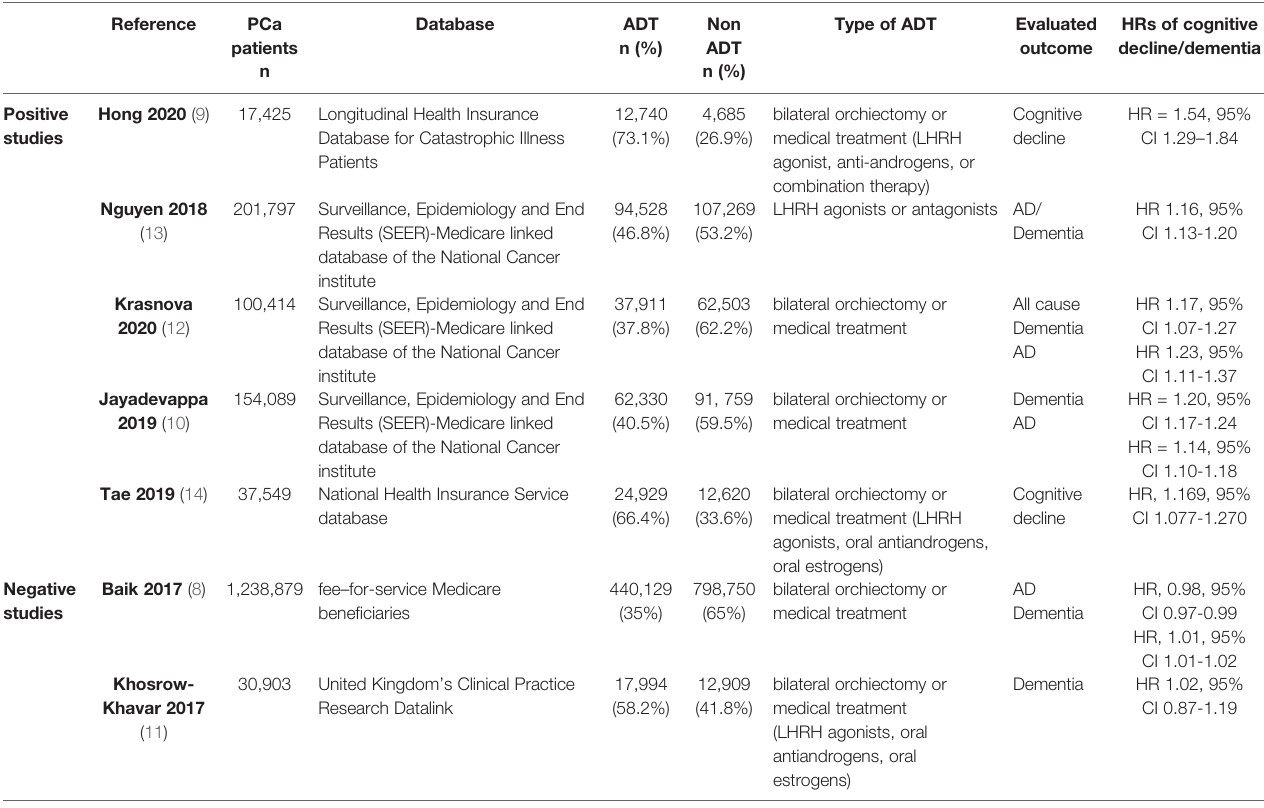
TABLE 1 | Retrospective cohort studies investigating association between androgen deprivation therapy and occurrence of cognitive impairment or Alzheimer ’ s disease in prostate cancer patients.